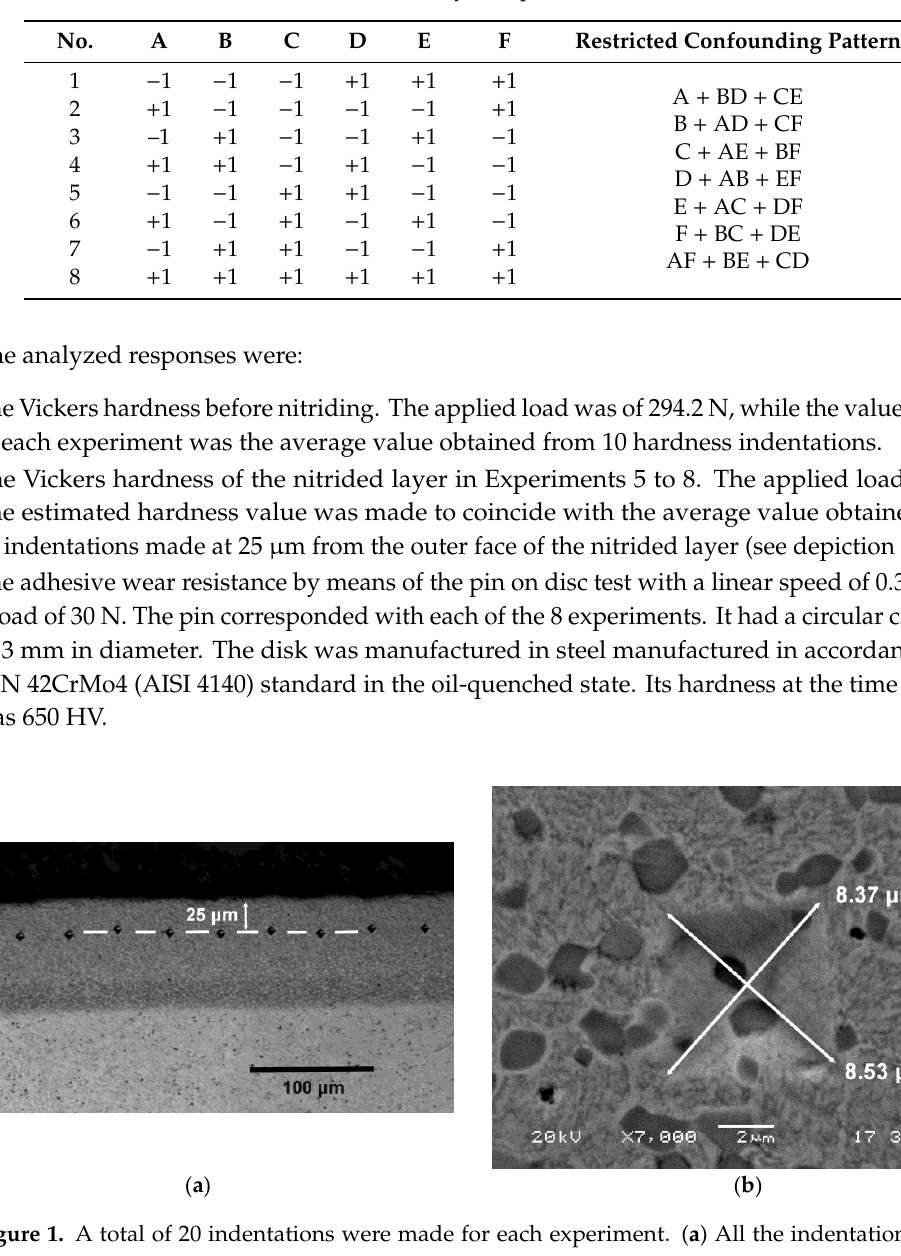
Table 3. Array of experiments.